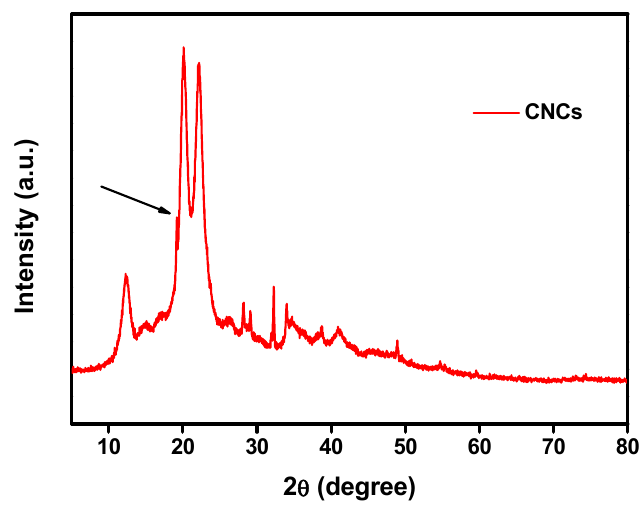
Figure 4. X-ray Di ff raction (XRD) patterns of CNCs. Figure 4. X-Ray Diffraction (XRD) patterns of CNCs. Figure 4. X-Ray Diffraction (XRD) patterns of CNCs.